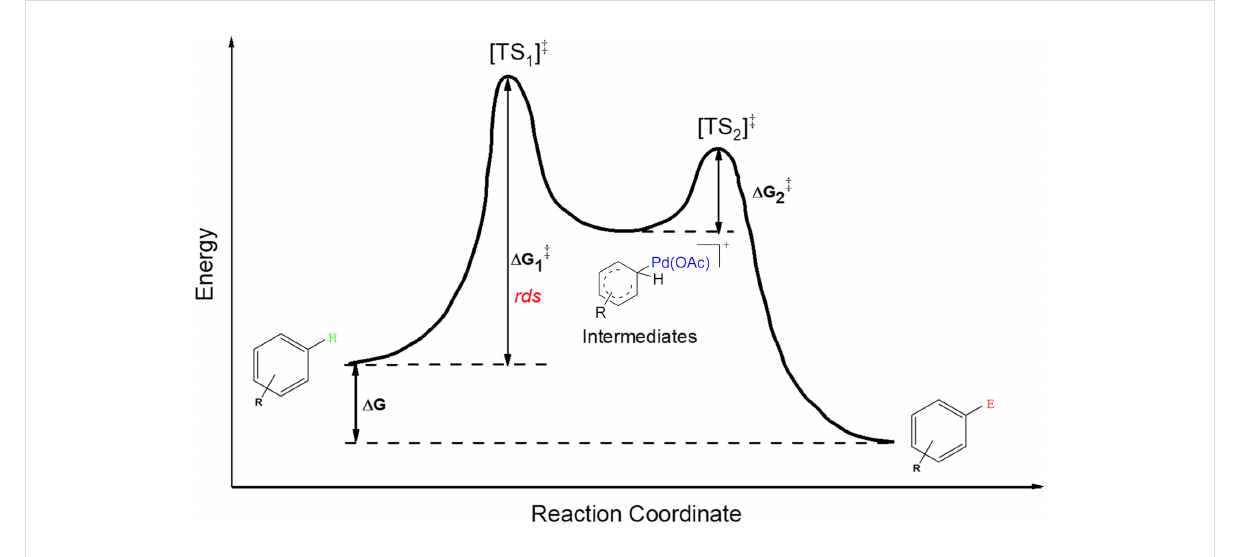
Figure 1: An approximate energy map for the electrophilic aromatic substitution